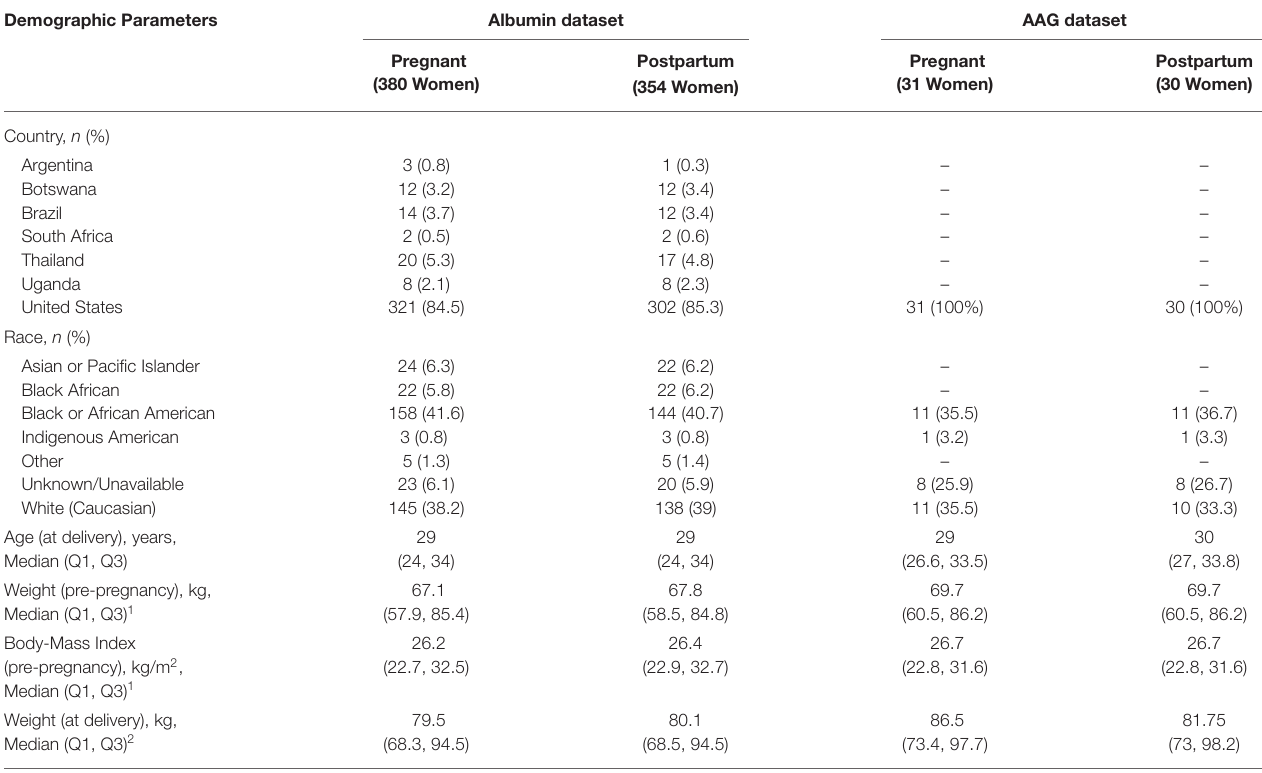
TABLE 1 | Demographic characteristics of the pregnant and postpartum women providing serum albumin and plasma AAG